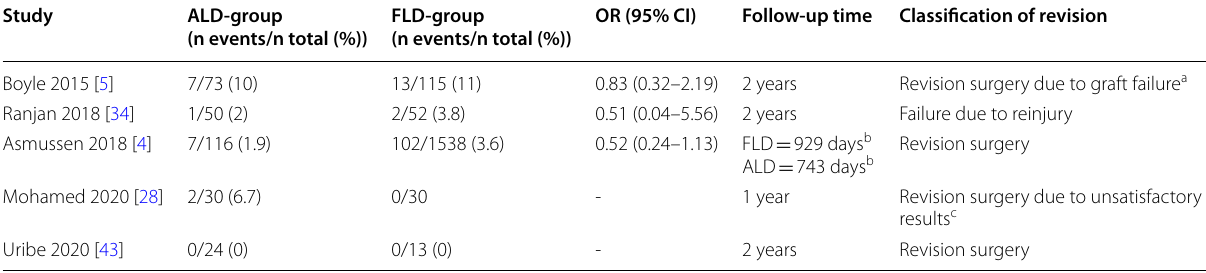
a Failure defined as either a grade 2 Lachmann, a positive pivot shift or an SSD greater than five millimetres + b Mean follow-up c Patients experiences giving away, locking and difficulties with climbing stairs